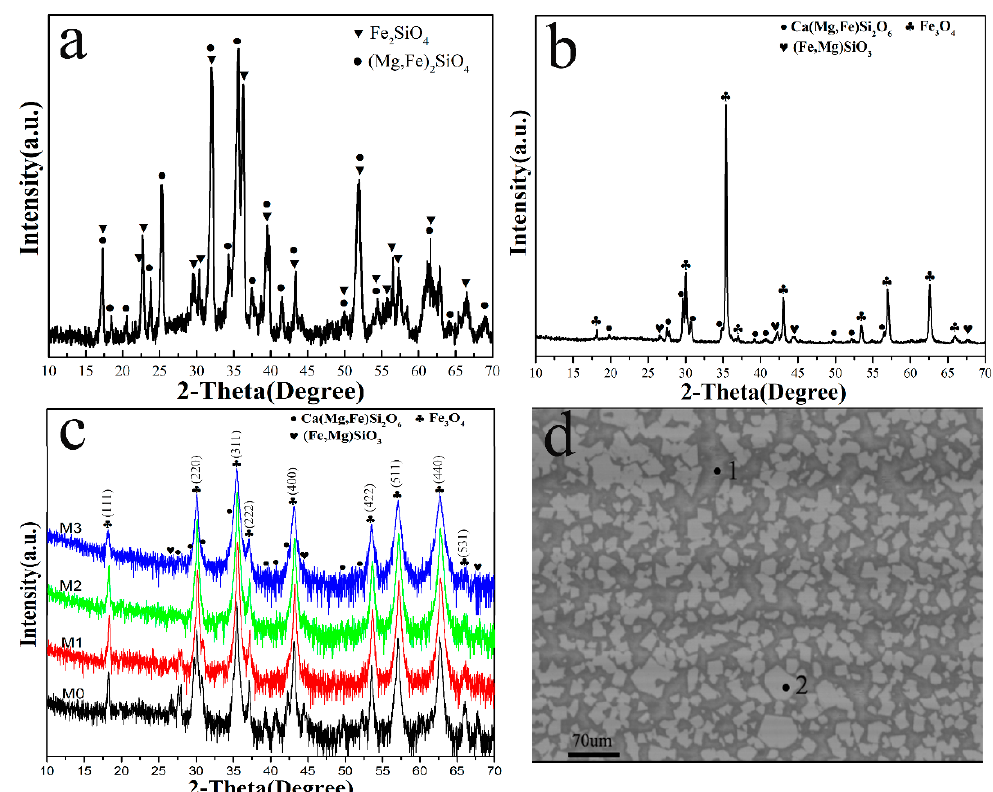
Figure 1. XRD pattern of nickel slag ( a ), XRD pattern of oxidized nickel slag ( b ), XRD patterns of MPs with different milling time ( c ), and backscattering electron image of oxidized nickel slag ( d ).